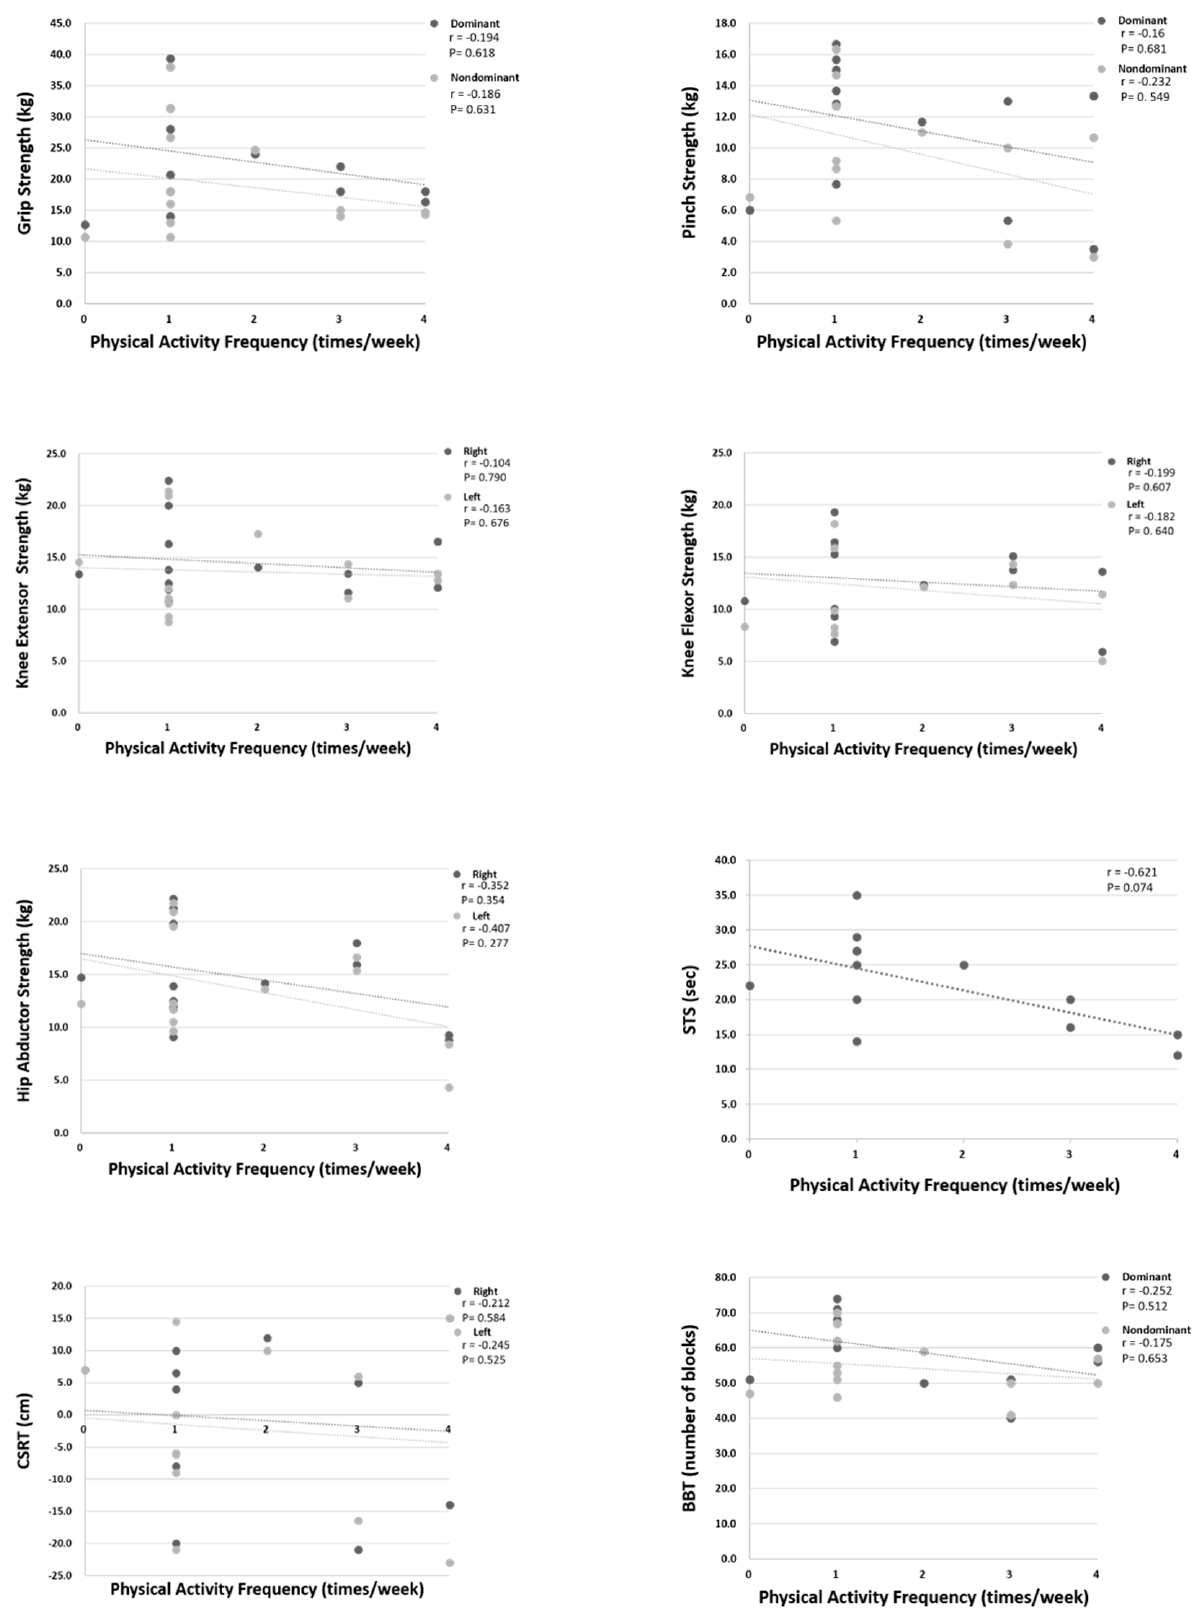
Figure 4. Correlations between exercise frequency and functional performances in the CD group.